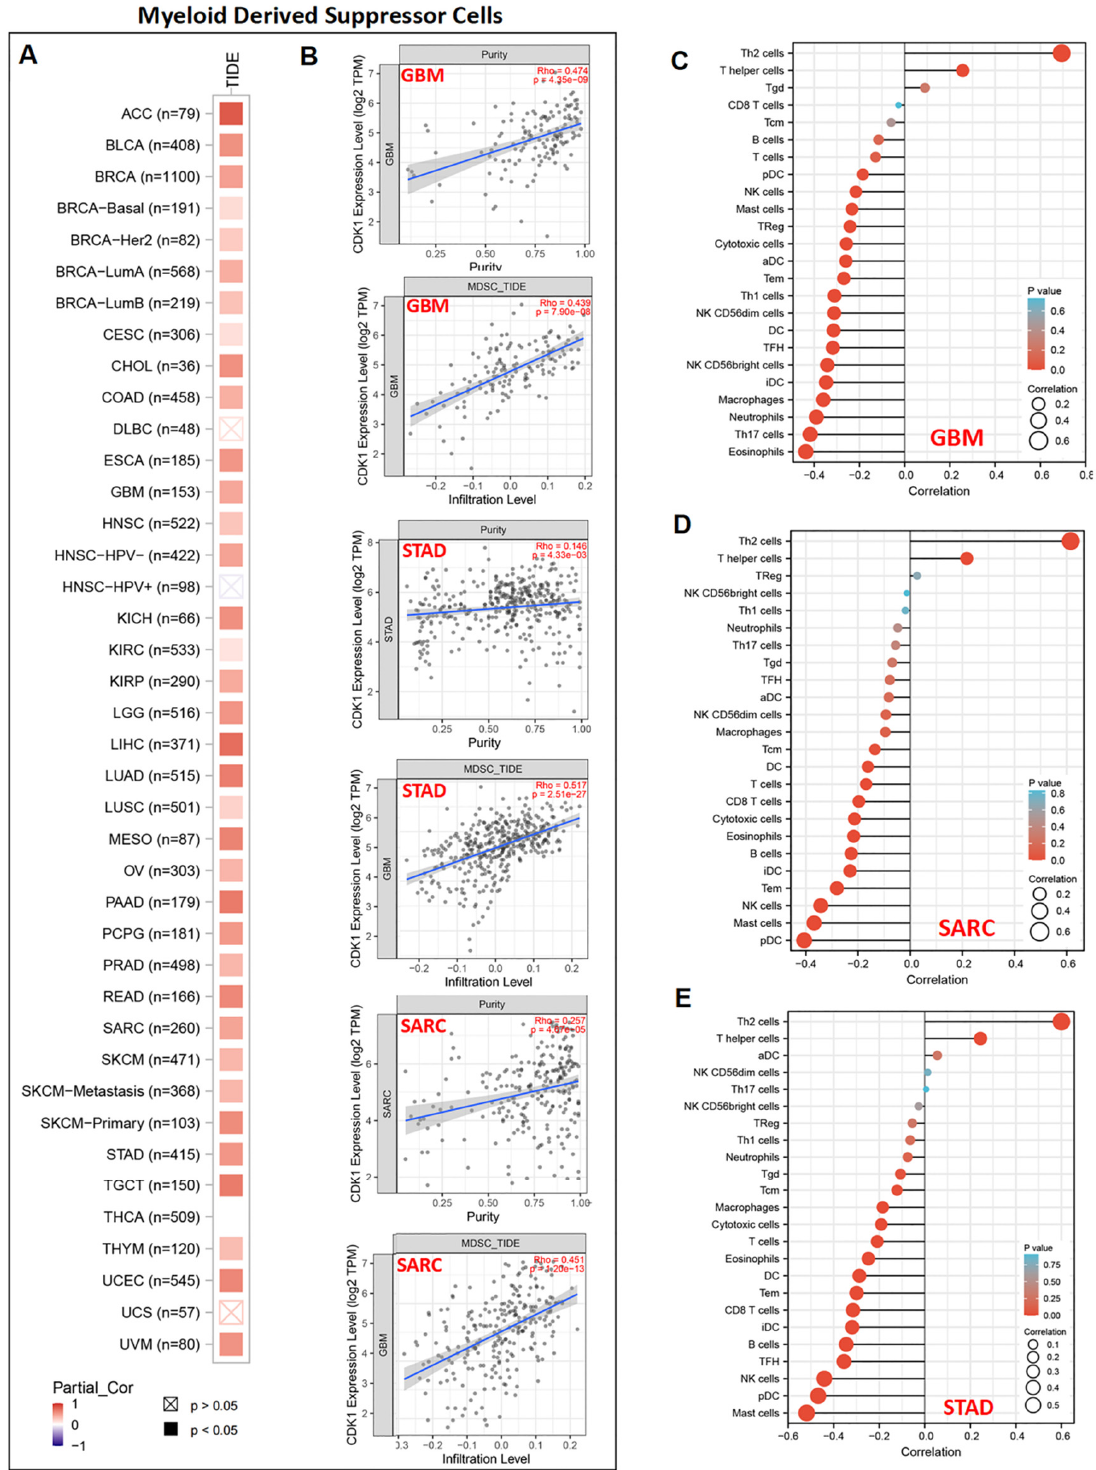
Figure 9. Association between CDK1 expression and immune infiltration. ( A , B ) The expression of CDK1 was positively related to MDSC infiltration in almost all of the tumors. Purity-adjusted Spear- man’s rho values, with TIDE algorithm. ( C – E ) The representative lollipop chart shows that CDK1 expression was significantly related to the infiltration of various innate and adaptive immune cells in GBM, SARC, and STAD.